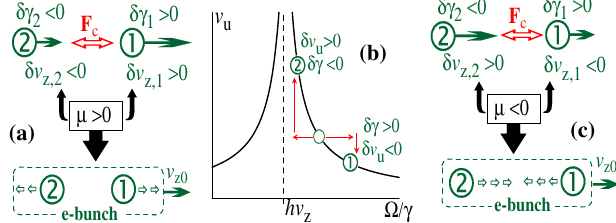
FIG. 3. The model of an electron bunch consisting of two particles. (a) Coulomb repulsion of the two particles in the positive-mass regime. (b) Typical dependence of the oscillatory (undulator) velocity of a particle on the cyclotron frequency. (c) Coulomb attraction of the two particles in the negative-mass